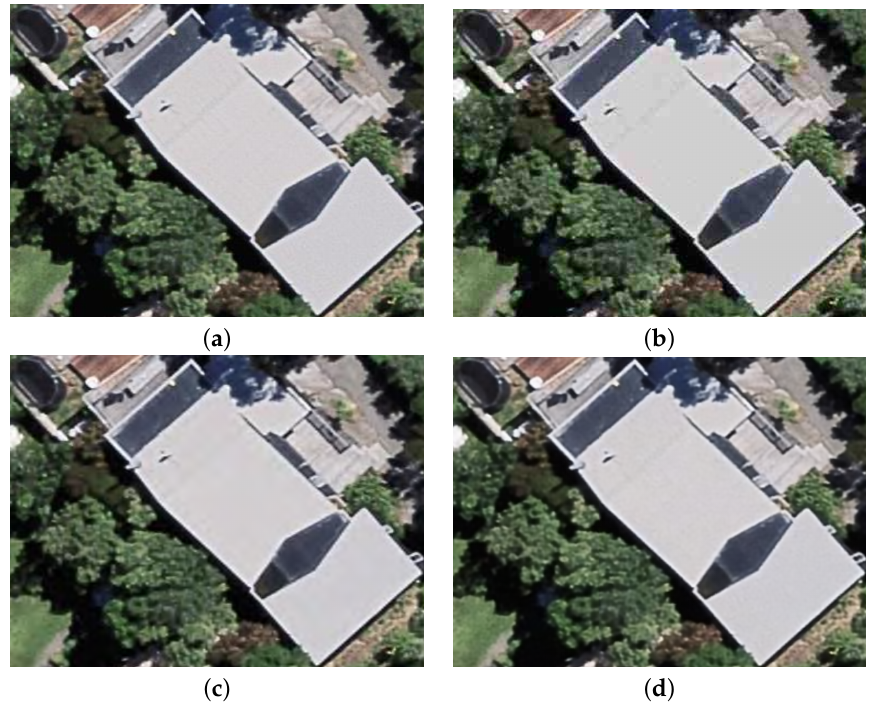
Figure 10. The visual performance. JPEG: 0.8254 bpp, PSNR 30.68 dB, MSSSIM 0.9788. JPEG2000: 0.7375 bpp, PSNR 32.74 dB, MSSSIM 0.9830. Ours: 0.7165 bpp, PSNR 34.68 dB, MSSSIM